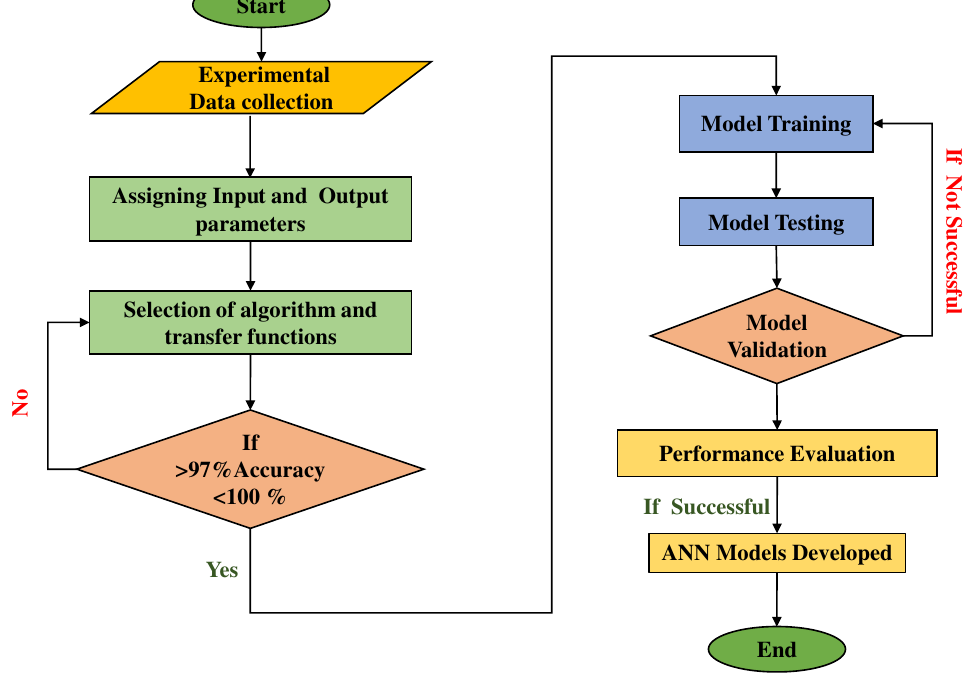
Figure 6. Overall proposed method for the developed ANN